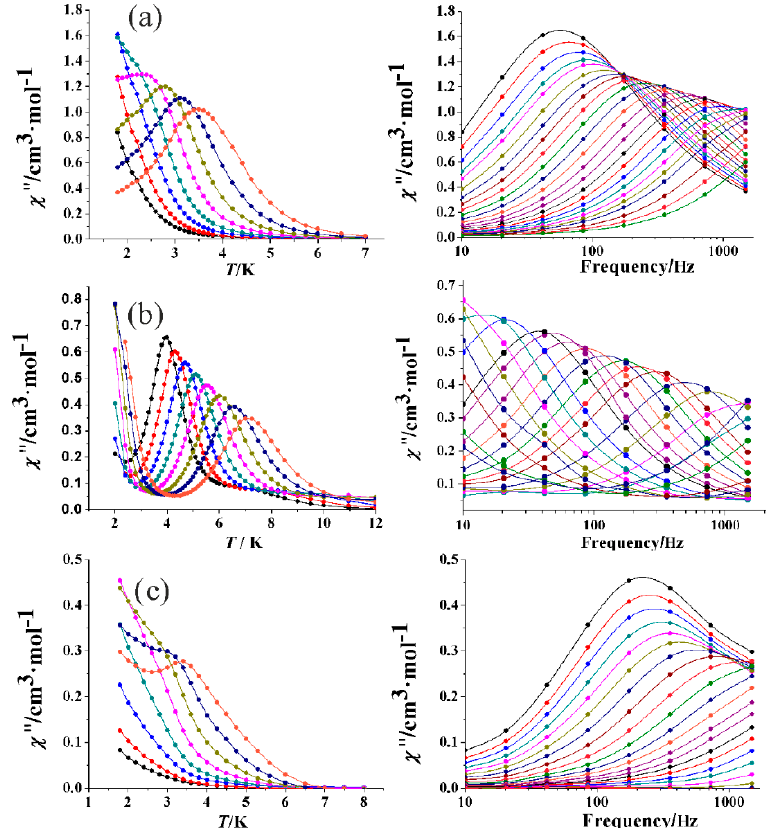
Figure 13. Out-of-phase ac molar magnetic susceptibility signals ( χ ″ ) vs. T (at different ac frequencies, left) and vs. ac frequency (at different low temperatures, right) for complexes ( a ) 7 _Dy, ( b ) 18 _Dy, and ( c ) 17 _Tb. All measurements were performed in the 10 to 1488 Hz frequency range under static field of 0.1 ( 7 _Dy, 18 _Dy) and 0.15 T ( 17 _Tb). Solid lines are guides for the eye.